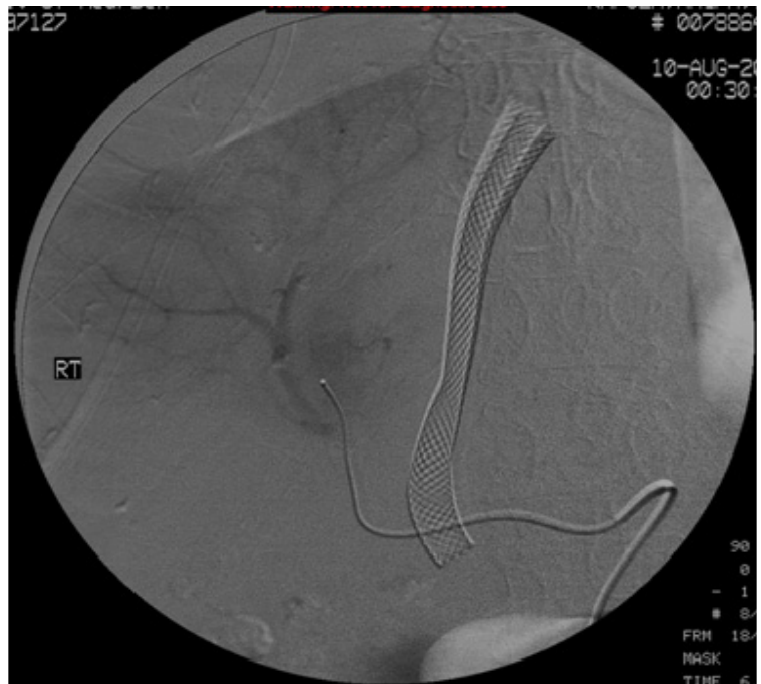
Figure 3. Delayed image of the arteriogram demonstrating the opacification of biliary tree, which indicates a fistula between hepatic artery and biliary